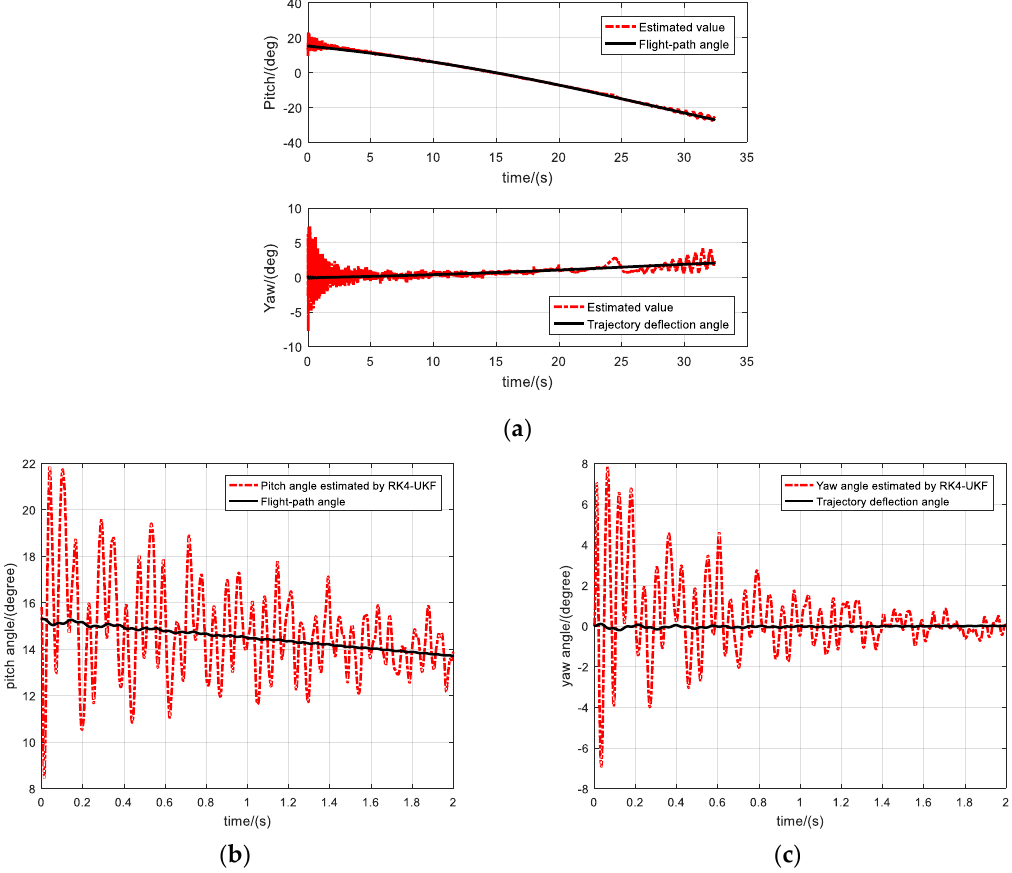
Figure 17. Pitch and yaw angles estimated by RK4-UKF. ( a ) Estimation of pitch and yaw of the entire ballistic, ( b ) Estimation of pitch angle in 2 s, ( c ) Calculation of yaw angle in 2 s.